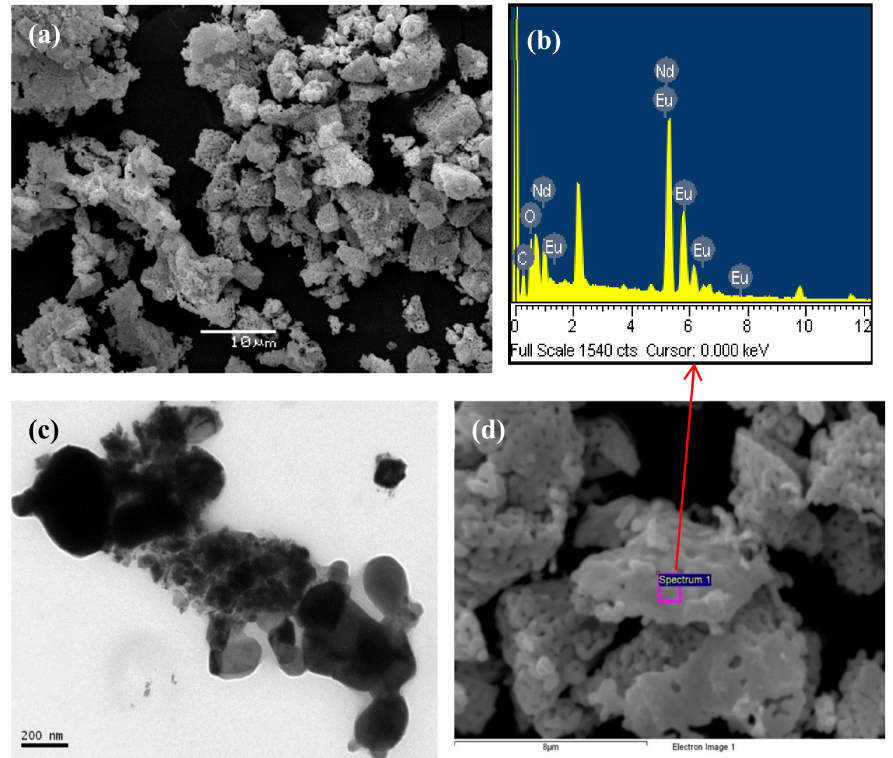
Figure 15. SEM ( a , d ), EDS ( b ), and TEM image ( c ) of the pyrolytic products from Eu 3+ doped, Chitosan · NdCl 3